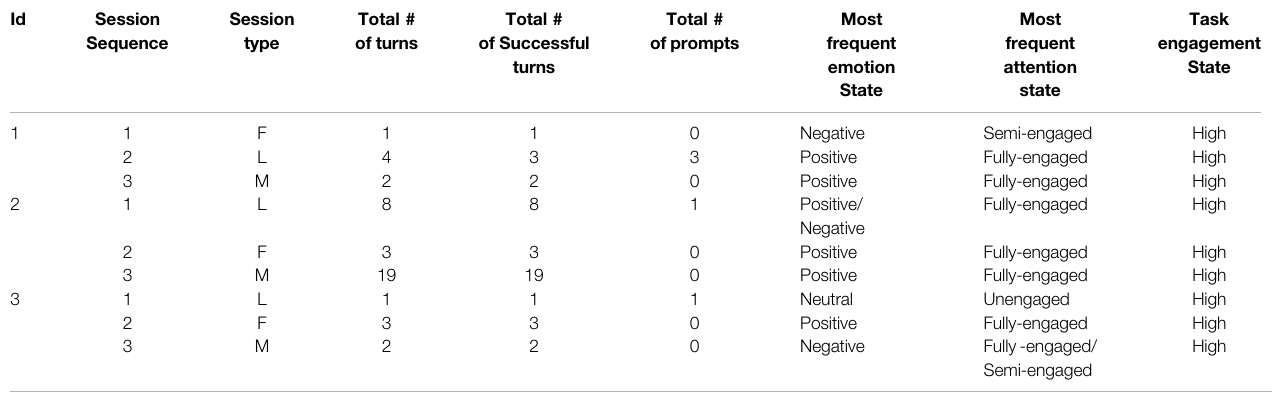
TABLE 3 | Summary metrics for the three participants from our user study that assesses the impact of interacting with the robot in single roles versus mixed roles on child engagement (L: Leader, F: Follower, M: Mixed).